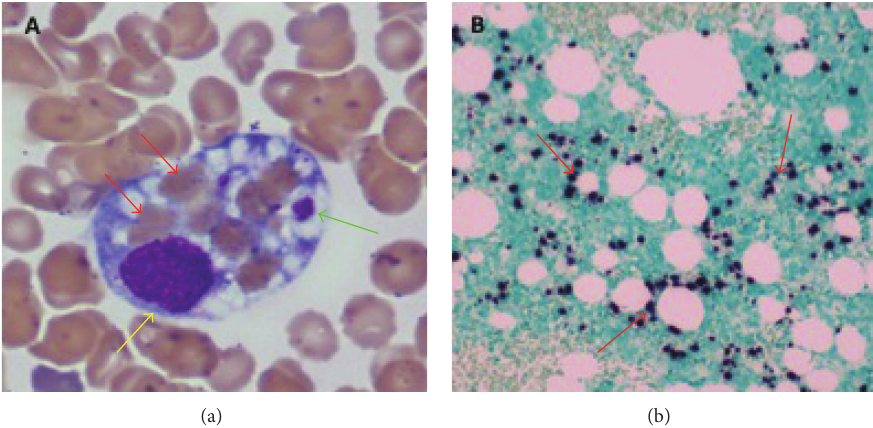
Figure 1: Images of the bone marrow. (a) Bone marrow aspirate smear, 1000x magnification, shows a hemophagocyte which engulfed 7 separate red blood cells (red arrows) and 2 platelets (green arrow). Yellow arrow points to a nuclei of histiocyte; (b) bone marrow clot section, EBV-encoded RNA (EBER) staining of the bone marrow revealing extensive EBV infected lymphocytes in the background (dark nuclear stain).